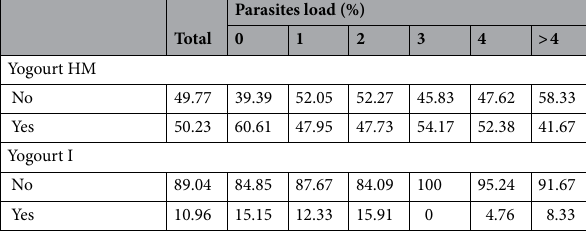
Table 1. Characteristics of the 219 Malagasy